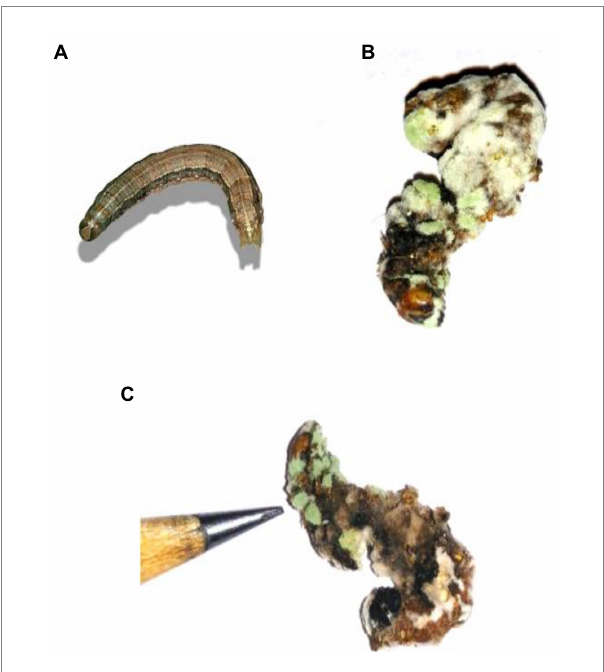
FIGURE 5 Cadaver of S. frugiperda after treatment with M. majus following 3, 6, 9, and 12 days of treatment under laboratory condition. (A) Control (without any conidia); (B,C) treatment with M. majus with results showing after 6 days of treatment. Fungi conidia had completely covered the cadaver of S. frugiperda .